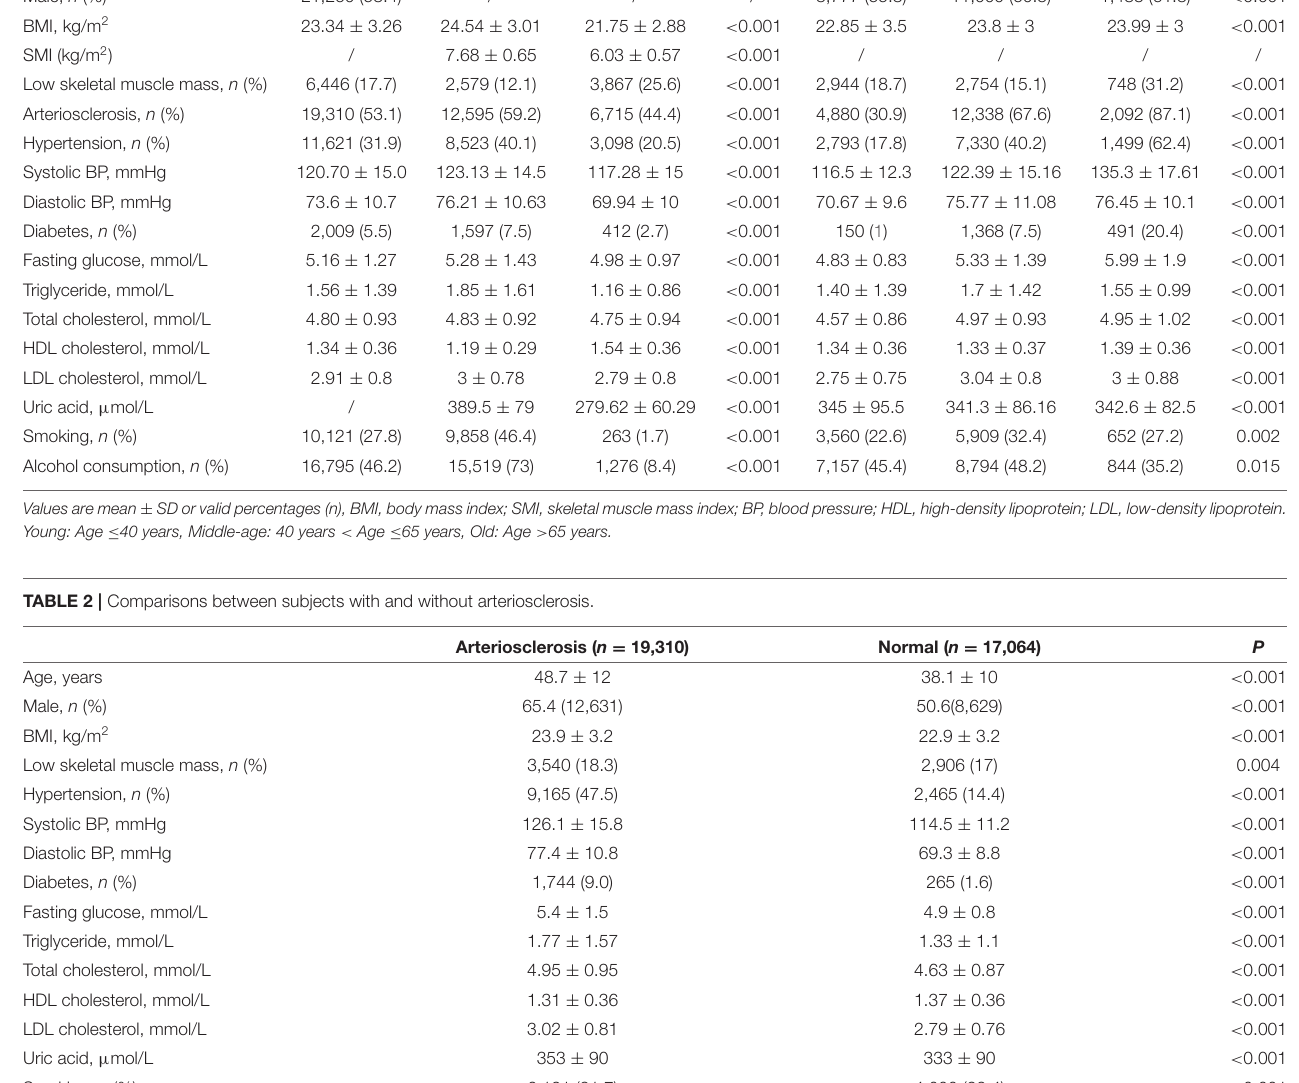
TABLE 1 | Demographic characteristics of all subjects. Overall Subgroups for gender Subgroups for age Men